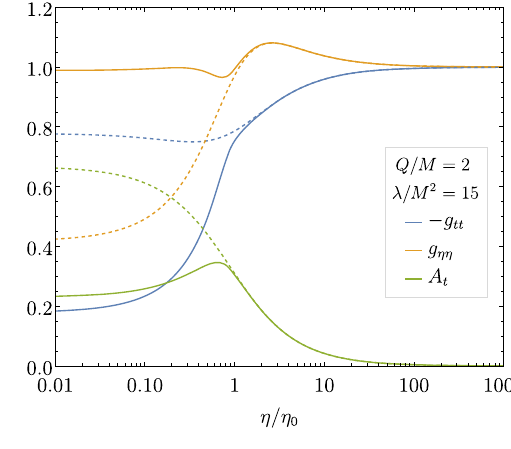
Fig. 3 Same as Fig. 1 for Q / M = 2 and λ/ M 2 = 15